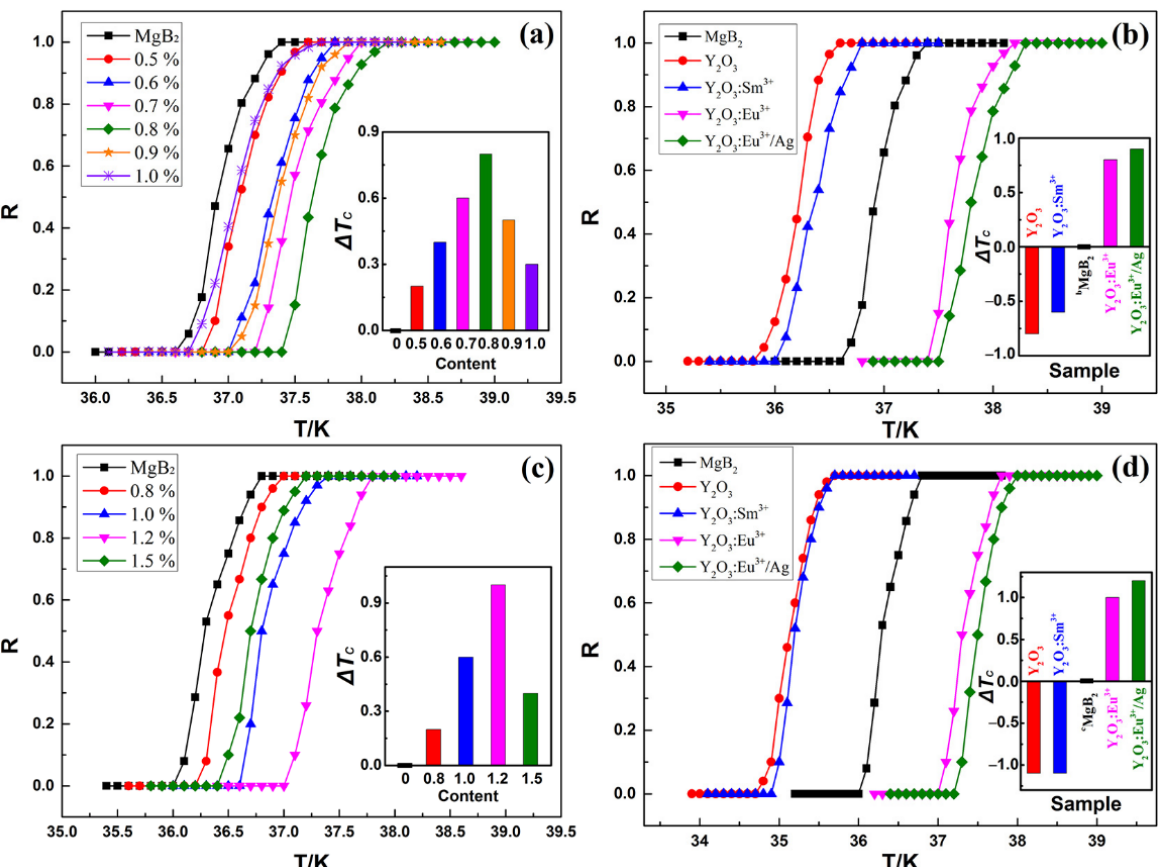
Figure 4. Normalized R–T curves of b MgB 2 doped with ( a ) x % Y 2 O 3 :Eu 3+ ( x = 0, 0.5, 0.6, 0.7, 0.8, 0.9, 1.0) and ( b ) 0.8% y ( y = 0, Y 2 O 3 , Y 2 O 3 :Sm 3+ , Y 2 O 3 :Eu 3+ , Y 2 O 3 :Eu 3+ /Ag). Normalized R–T curves of c MgB 2 doped with ( c ) x % Y 2 O 3 :Eu 3+ ( x = 0, 0.8, 1.0, 1.2, 1.5) and ( d ) 1.2% y ( y = 0, Y 2 O 3 , Y 2 O 3 :Sm 3+ , Y 2 O 3 :Eu 3+ , Y 2 O 3 :Eu 3+ /Ag). Insets: the values of Δ T c ( Δ T c = T c − T cpure ).